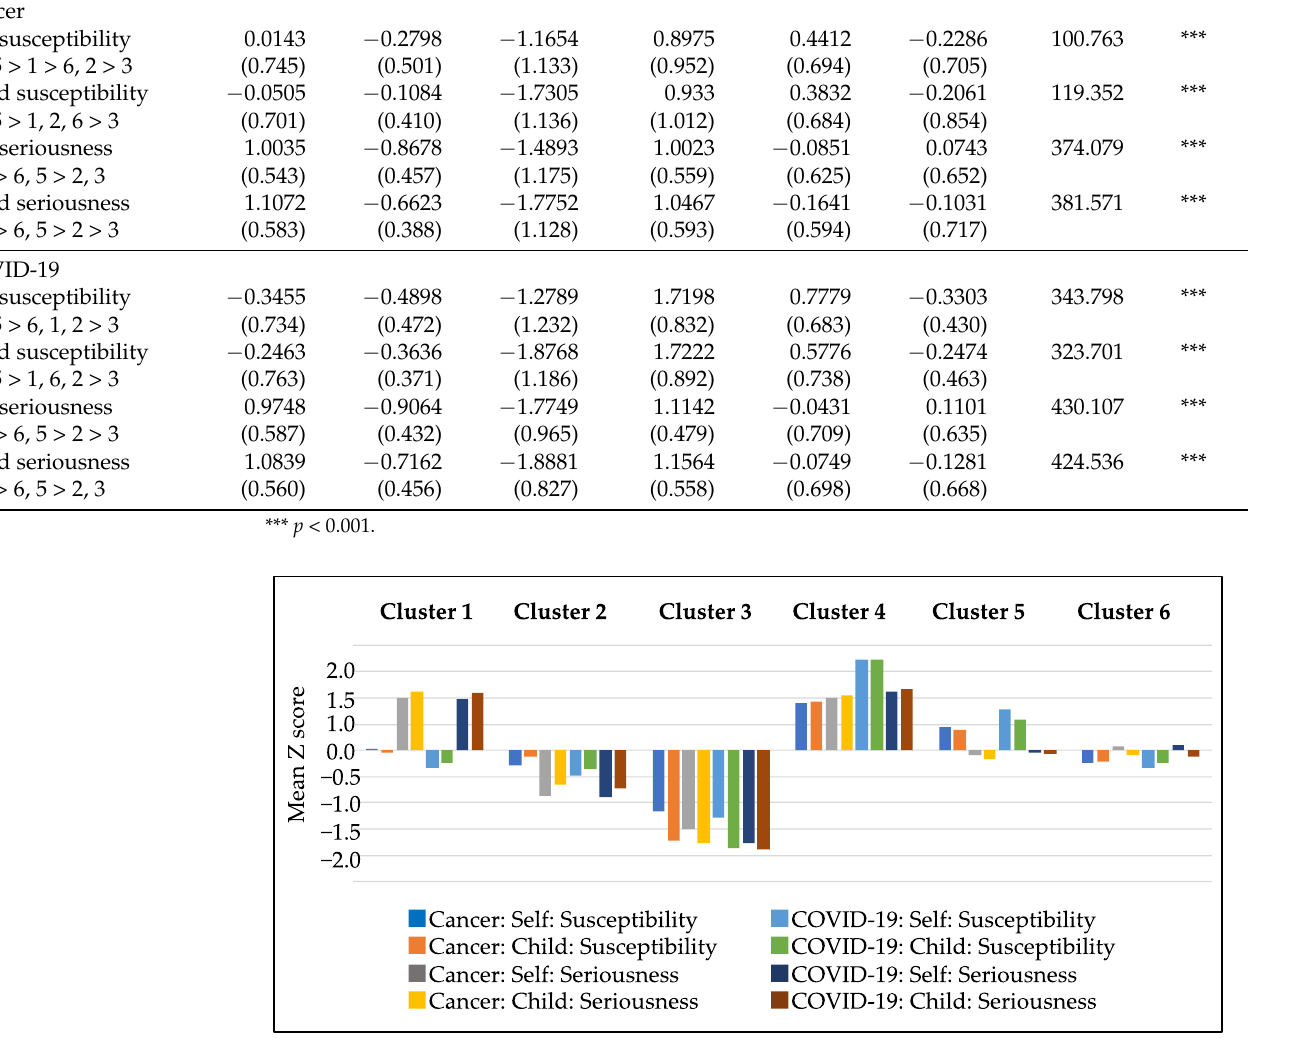
Figure 2. Clustered bar graph by susceptibility and seriousness of cancer and COVID-19.